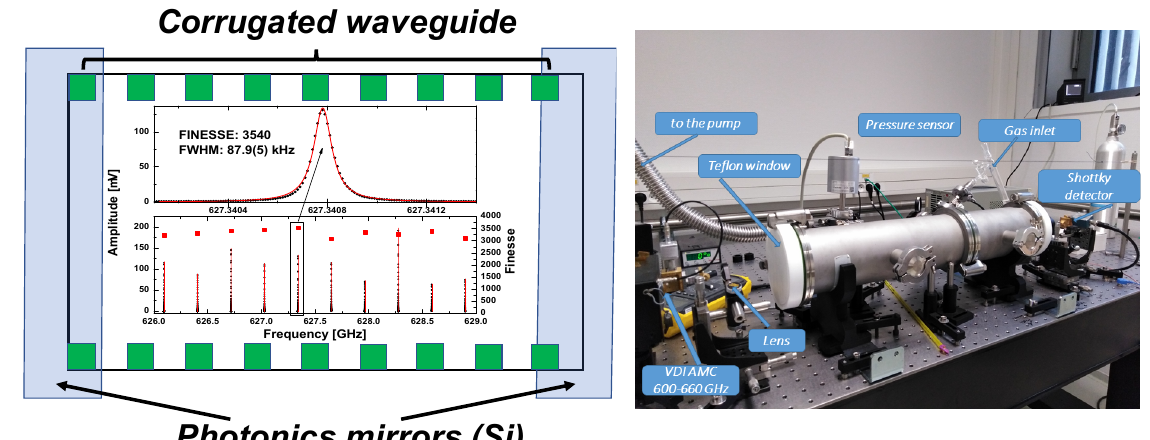
Figure 5. Left: Scheme of the Fabry-Perot THz cavity based on a low-loss oversized corrugated waveguide with highly reflective photonic mirrors. Successive cavity modes are shown inside the cavity scheme and an achieved finesse above 3500 in the 626–629 GHz frequency range is highlighted ( L ef f . > 1.1 km). Right: Picture of the FP-THz absorption spectrometer with some